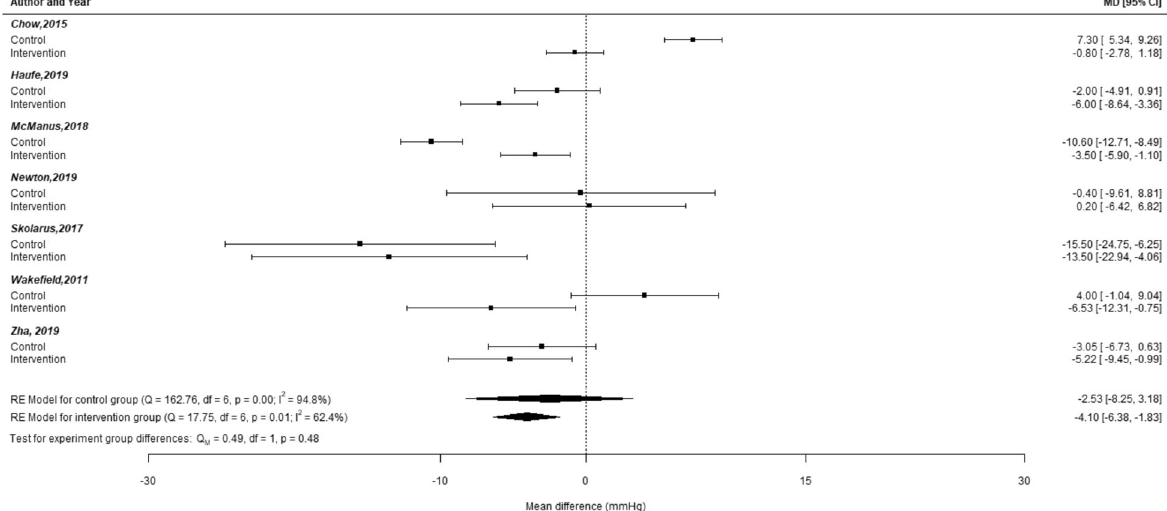
Fig. 2 Plot of mean differences in SBP change between the intervention group and control group at 6-months for RCTs included in meta- analyses. Forest plot of the mean difference in systolic blood pressure (SBP) within the experimental group. The top portion of this fi gure shows the mean difference (MD) in SBP at 6 mo within the intervention or control group for each study. Error bars for each study signify the 95% con fi dence intervals for the mean difference within the control group or intervention group for each study. The control groups for all studies were combined to create an estimated average effect in a random-effects model. A similar procedure was done for the intervention groups. The summary polygons at the bottom of the plot show results of random-effects models. Among all participants in the intervention group, there was a statistically signi fi cant decrease in the mean difference for SBP change. However, this mean difference estimate was not signi fi cantly different from the estimate from the control group (test for experimental group difference: p = 0.48).